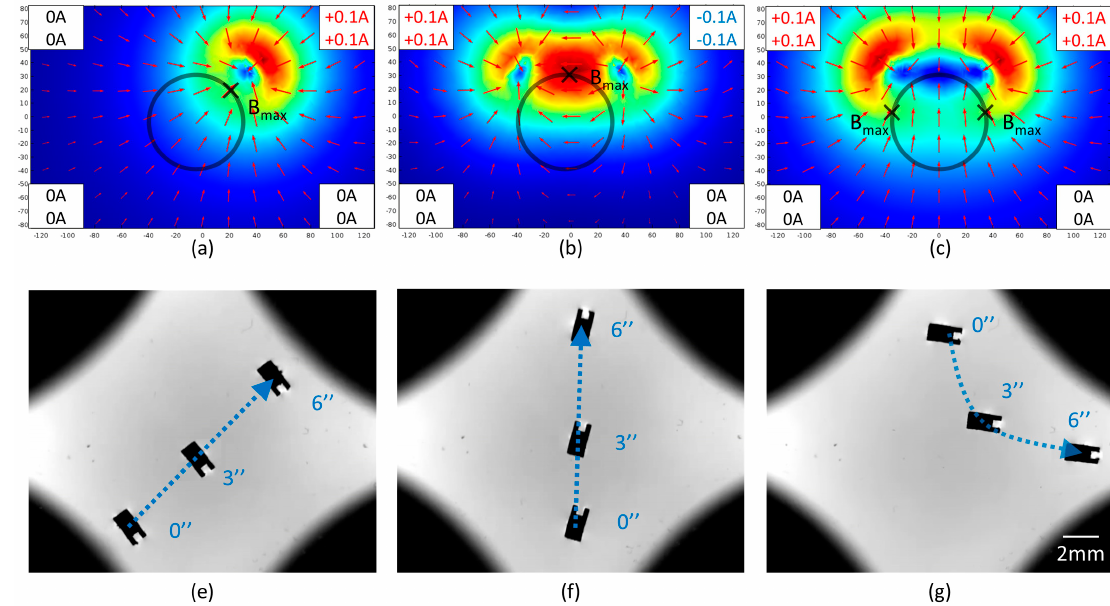
Figure 7. ( a – c ) Simulation of magnetic field distribution in three cases. The color and the arrow represent the magnitude and direction of the magnetic field respectively. The workspace and local maximum were marked by circles and crosses individually. ( e – g ) Images of the micromachine’s trajectory in three cases. The micromachine was magnetized at 90°.